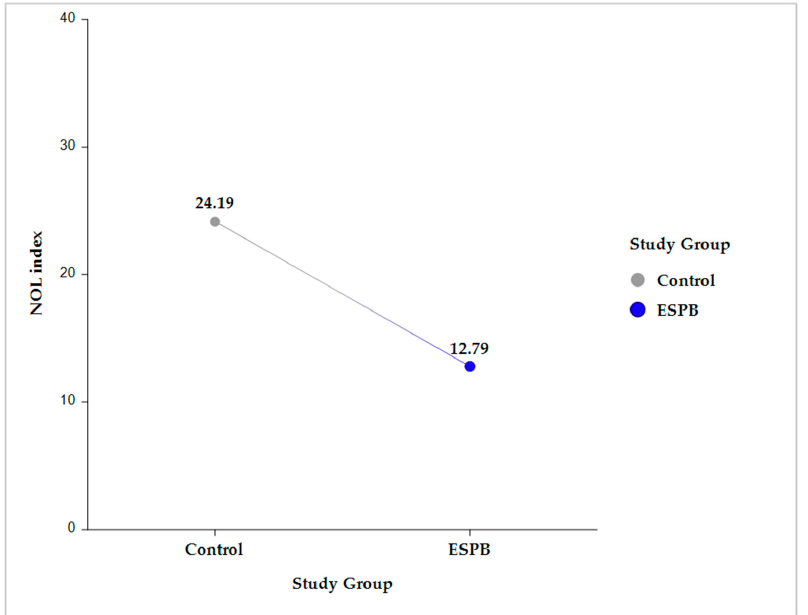
Figure 2. Intergroup comparison (Control vs. ESPB) for the average NOL index value across the five sampling time points. The data are presented as least square adjusted means. For Control vs. ESPB, p < 0.001. Analysis was performed using a mixed model for repeated measurement with random intercepts for patients and fixed effects for group, time, and the interaction of group and time. ESPB, erector spinae plane block; NOL, nociception level.